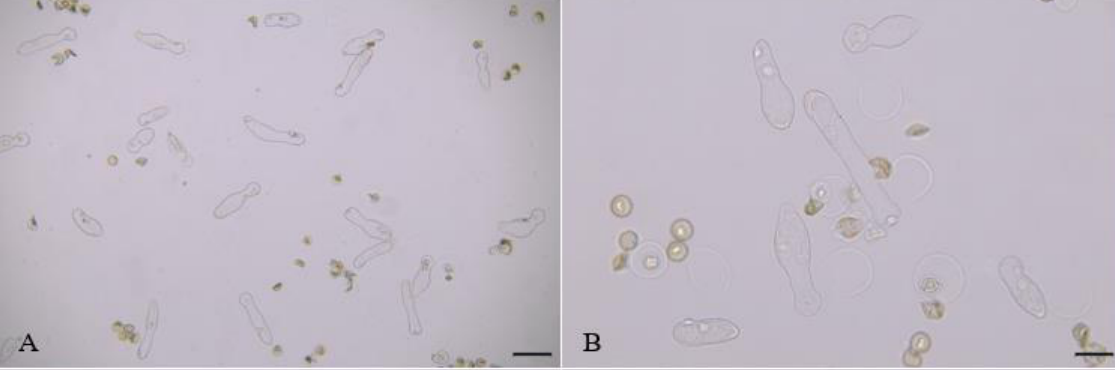
Figure 3. Pollen germination of T. distichum var. distichum in vitro. ( A ) Observation of pollen germination at 10×. ( B ) Observation of pollen germination at 20×. ( C ) Two tubes branched from the same pollen tube ( arrow ). ( D ) Two tubes generated from two parts of the pollen grain. Bars: ( A ) 100 μm. ( B – D ) 50 μm. Table 4. The effect of different mass fraction of boric acid on pollen germination of T. distichum var. distichum. Treat